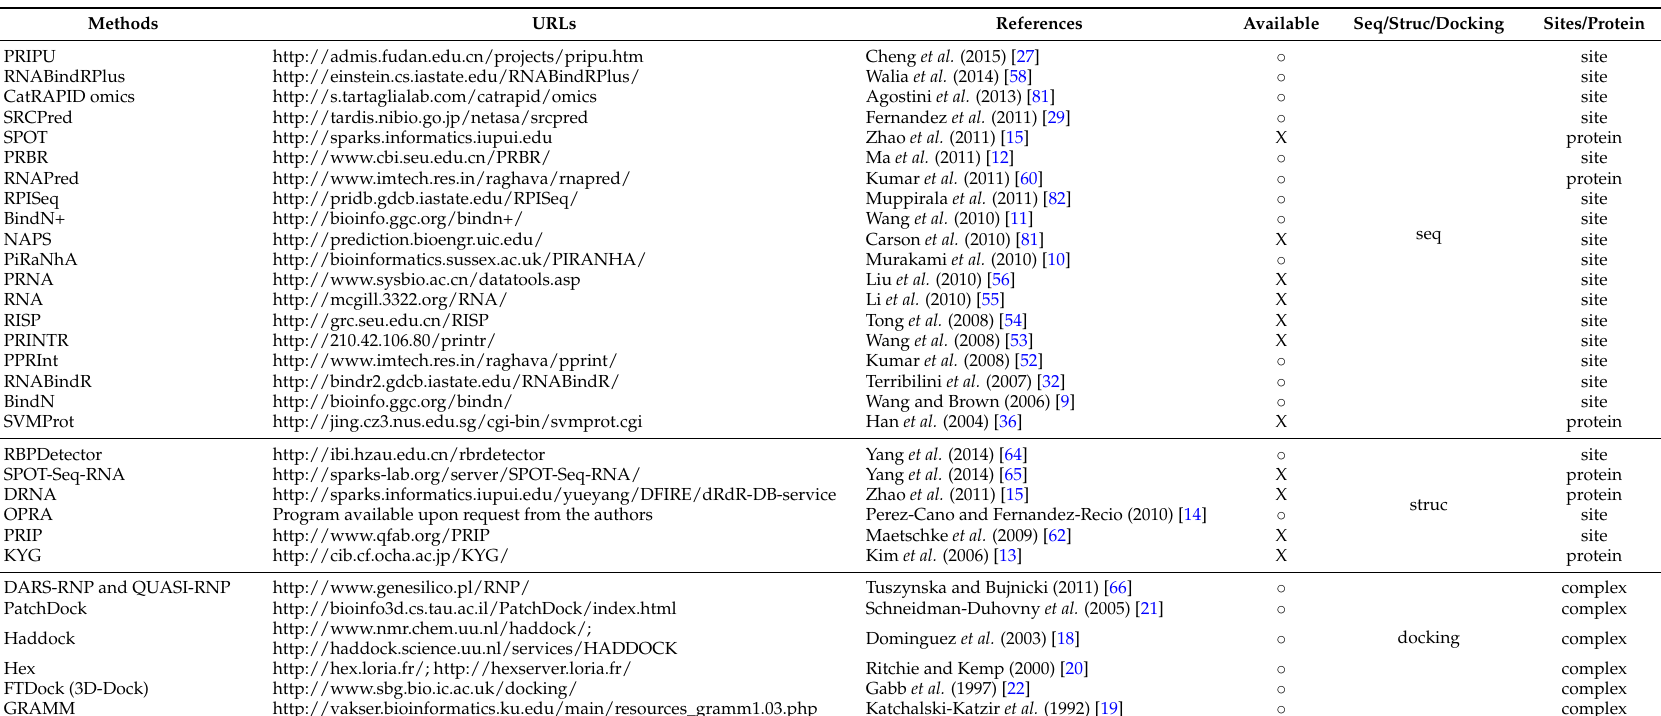
Table 2. A general selection of Web servers of RNA-binding sites and protein prediction and protein–RNA complex